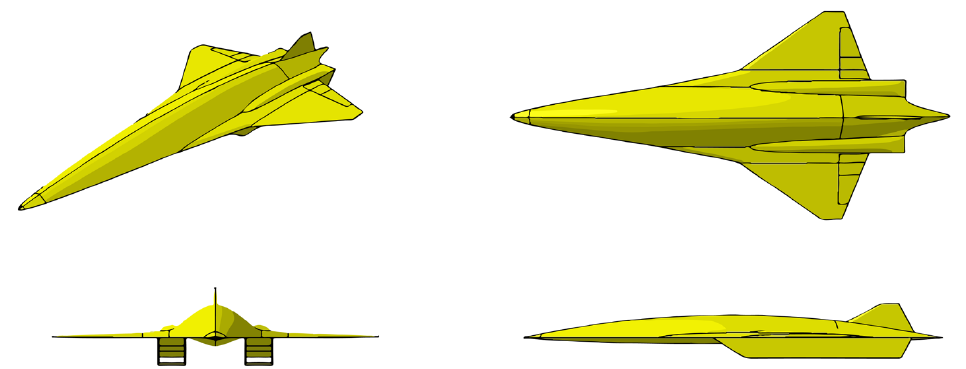
Figure 3. Overall configuration of the illustrative aircraft.